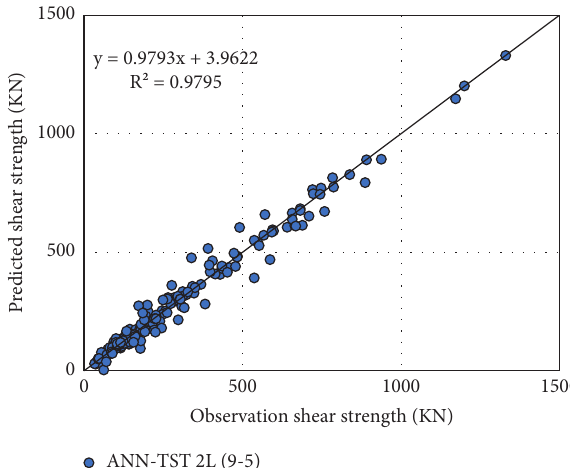
Figure 7: Target (experimental) versus predicted values of shear strength for ANN-TST 2L (9-5) model using all